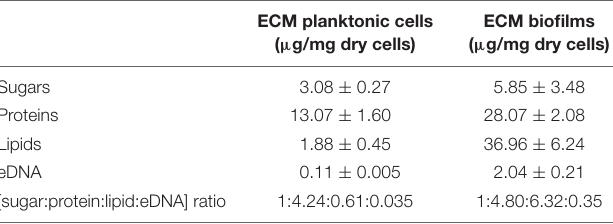
The ECM of 2 days-old planktonically grown cells and 5 days-old biofilm-grown Mabs NJH12 cells was collected and processed for DNA, lipid, protein, and sugar quantitative and qualitative analysis as described under section “Materials and Methods.” Bacterial cells recovered after their ECM was removed were freeze- dried and weighed. The amounts of ECM-derived DNA, lipids, proteins, and sugars provided below are expressed relative to the dry weight of bacilli stripped of their ECM. Shown are averages ± SD of triplicate